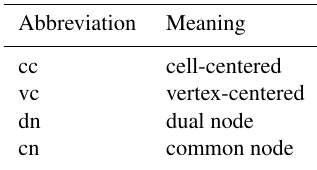
Table 1. Abbreviations used in the